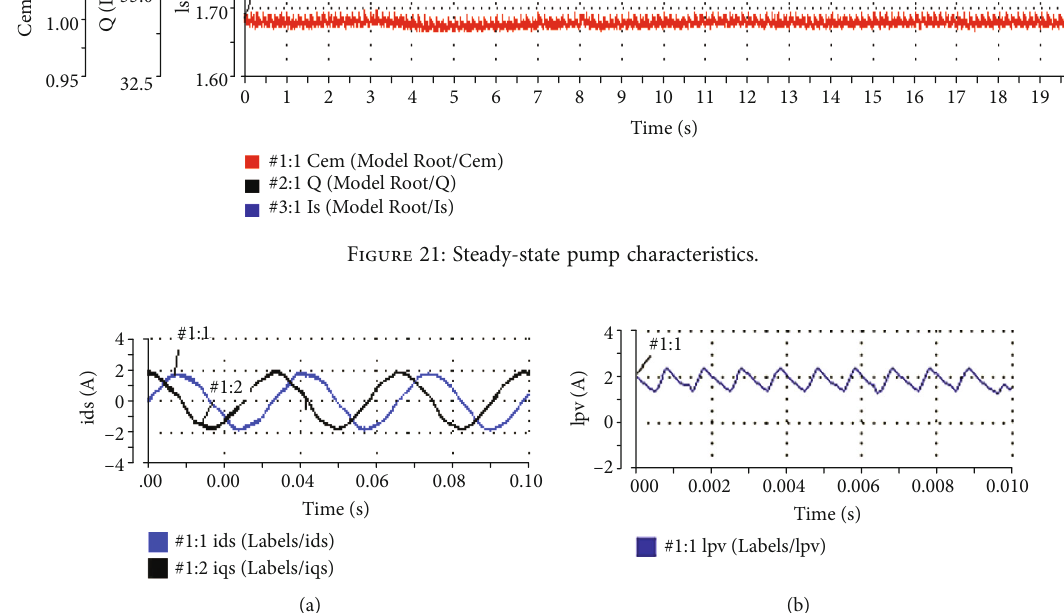
Figure 22: Currents response: (a) zoom on direct and quadratic components I